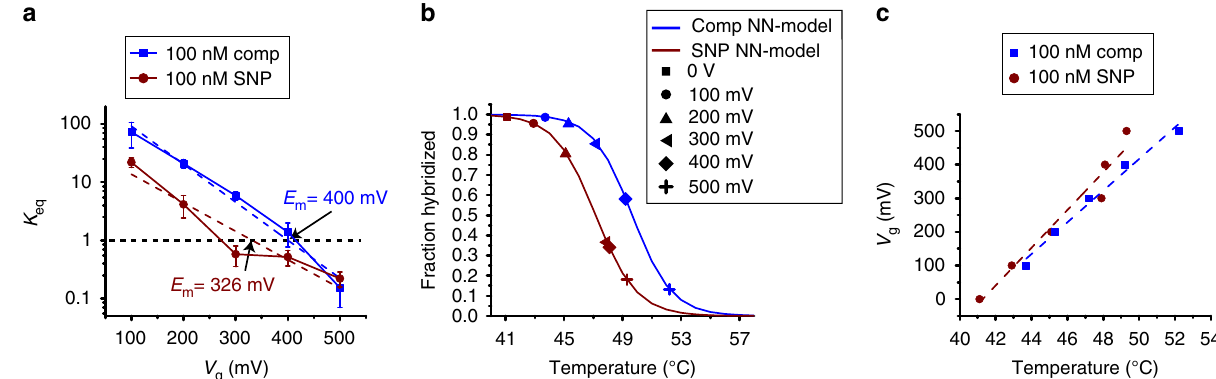
Figure 6 | Sequence-dependent effects of electrostatic force. ( a ) Dependence of K eq on V g , demonstrating higher values for the complementary compared to the SNP across all V g values. K eq ¼ 1 defines a melting potential of E m ¼ 400.05 ( ± 2.55) mV for the complementary target and E m ¼ 326.45 ( ± 1.33) mV for the SNP; R 2 values for the SNP and comp are 0.95 and 0.97, respectively. Error bars are calculated from five different 60-s intervals at each bias value. ( b ) An effective T m curve showing the extrapolated temperatures for each hybridized fraction of both complementary and SNP target against their perspective nearest-neighbour models; and ( c ) calibration curves demonstrate the interchangeable effect of bias and temperature on reaction rates and further correlate each bias point with an effective